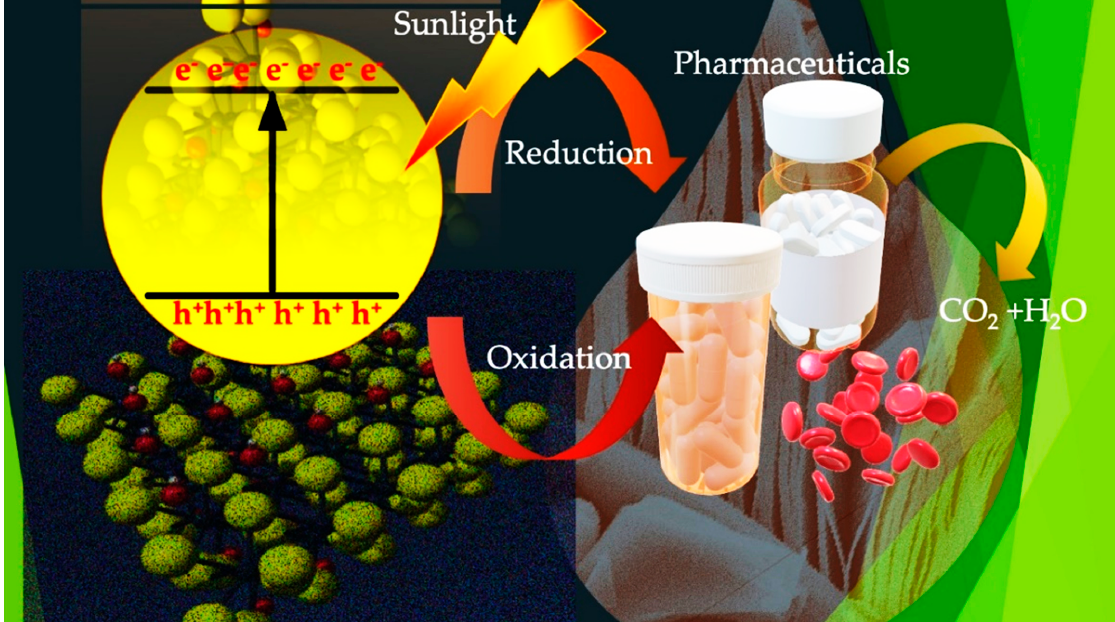
Figure 8. The mechanism for photocatalytic elimination of pharmaceutical wastes using MXene composite as a photocatalyst